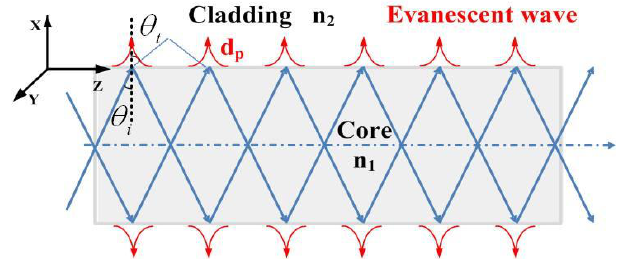
Figure 1. Schematic representation of the light path in optical